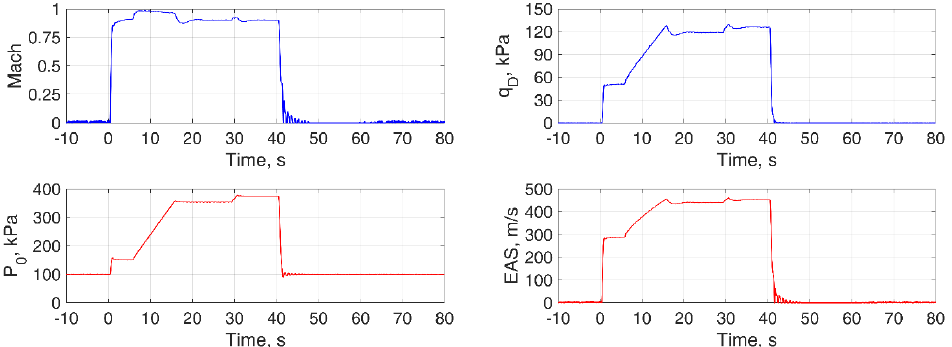
Figure 15. Aerodynamic conditions during the transonic flutter testing.